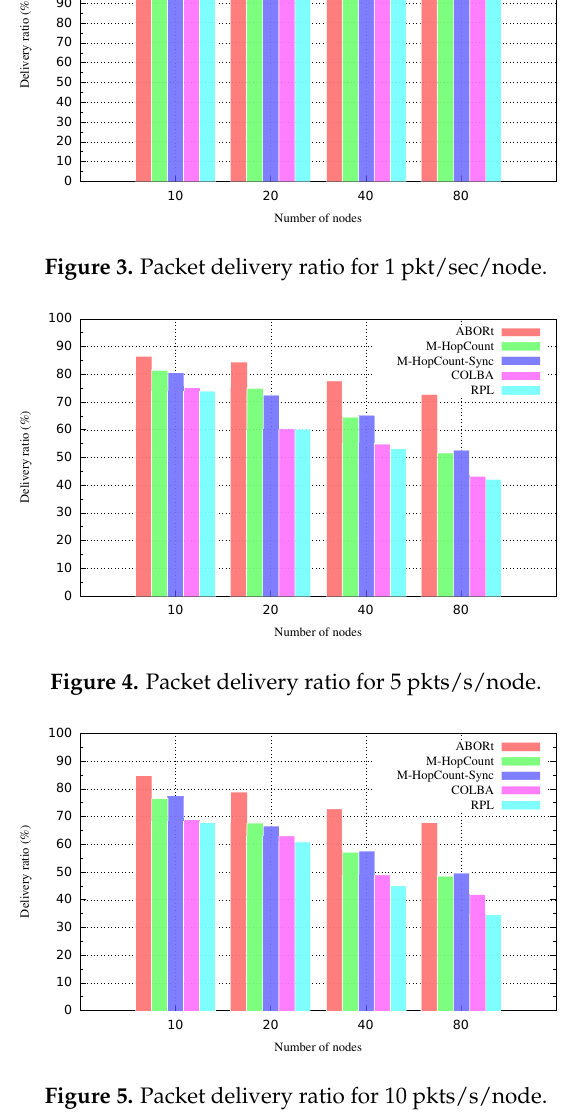
Figure 5. Packet delivery ratio for 10